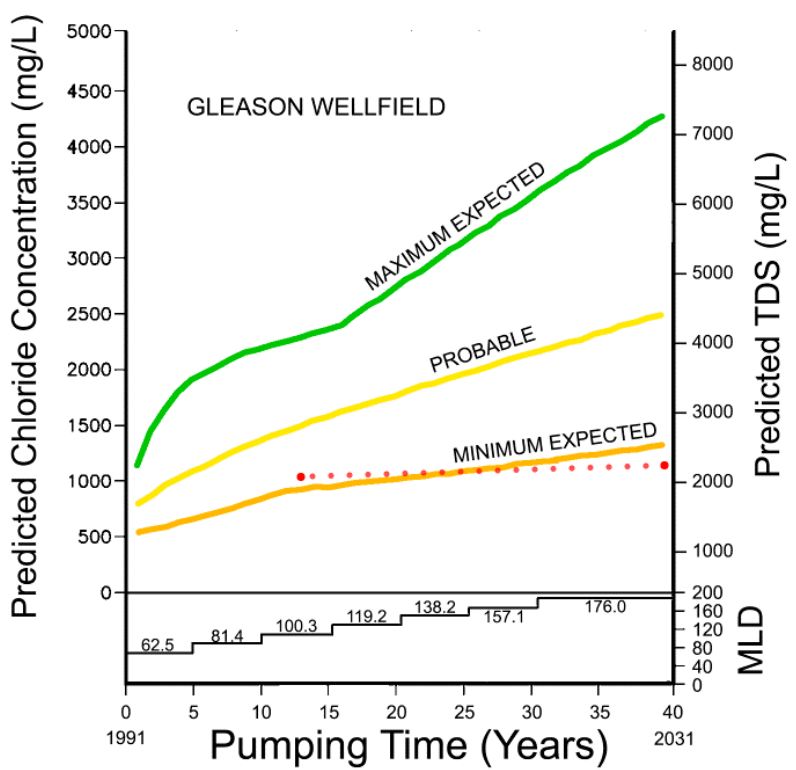
Figure 14. Original planning model projected dissolved chloride change for the South Wellfield along with the average values obtained from real data [12]. The actual data are shown from 2003 to 2020 (red dots), and the projection based on the trend analysis is shown up to 2031.